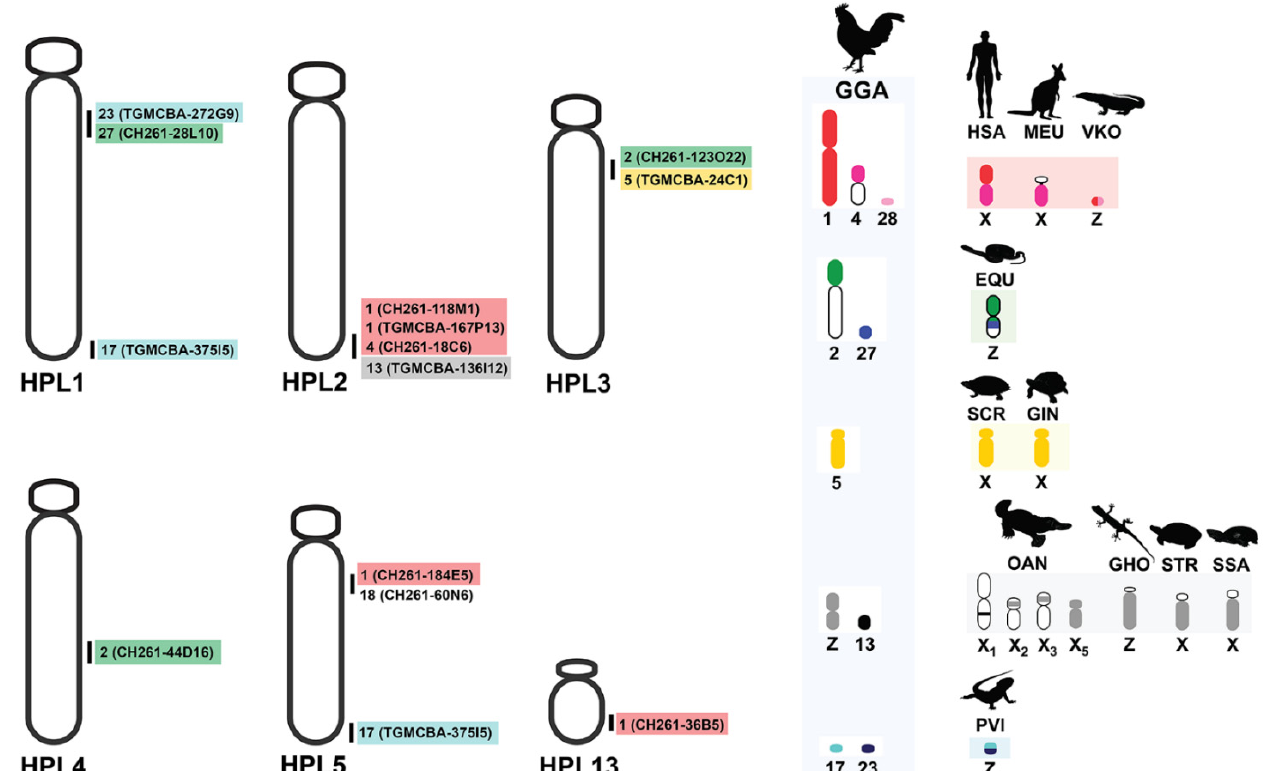
Figure 4. Chromosome map of the flat-tailed house gecko ( Hemidactylus platyurus , HPL) (Schneider, 1797) [73], showing chromosome homologies with chicken and zebra finch. This map was constructed with 13 chicken and zebra finch BACs mapped on the flat-tailed house gecko chromosome 1–5 and chromosome 13. Locations of BACs are shown to the right of the flat-tailed house gecko chromosomes. The chromosome numbers show the chromosomes of the chicken ( Gallus gallus, GGA) (Linnaeus, 1758) [54] and zebra finch ( Taeniopygia guttata , TGU) (Vieillot, 1817) [91] homologous to the flat-tailed house gecko chromosomes, and chromosomes sharing homologies with sex chromosome of several other amniotes. Partial sex chromosomal linkage homologies are shown in the same color. Chromosomal locations of genes in the amniotes were obtained from comparative gene mapping (chromosome mapping via a cytogenetic technique) and whole genome sequencing as the following sources: ( Gallus gallus, GGA) from Matsuda et al. [57], humans ( Homo sapiens , HSA) and tammar wallaby ( Macropus eugenii , MEU) from Grützner et al. [58], duck-billed platypus ( Ornithorhynchus anatinus , OAN) from Veyrunes et al. [59], bearded dragon lizard ( Pogona vitticeps , PVI) from Ezaz et al. [61], Hokou gecko ( Gekko hokouensis , GHO) from Kawai et al. [21], Komodo dragon ( Varanus komodoensis , VKO) from Lind et al. [65], Japanese four-striped rat snake ( Elaphe quadrivirgata , EQU) from Matsubara et al. [66], marsh turtle ( Siebenrockiella crassicollis , SCR) from Kawagoshi et al. [67], wood turtle ( Glyptemys insculpta , GIN) and Mexican musk turtle ( Staurotypus triporcatus , STR) from Montiel et al. [68], and giant musk turtle ( Staurotypus salvinii , SSA) from Kawagoshi et al. [69].